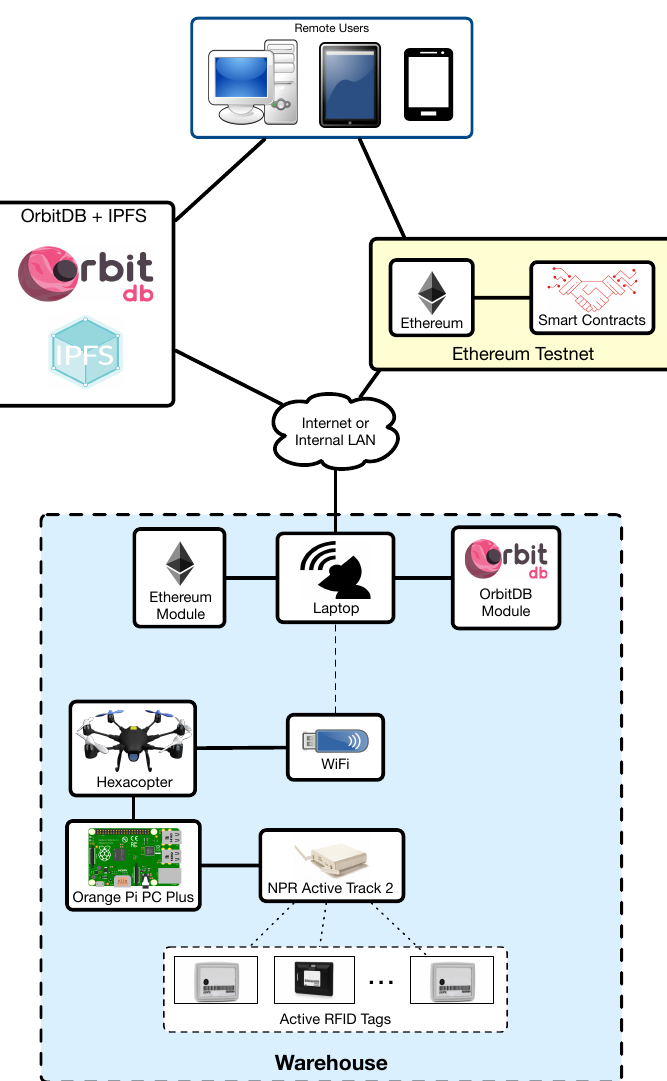
Figure 4. Implemented